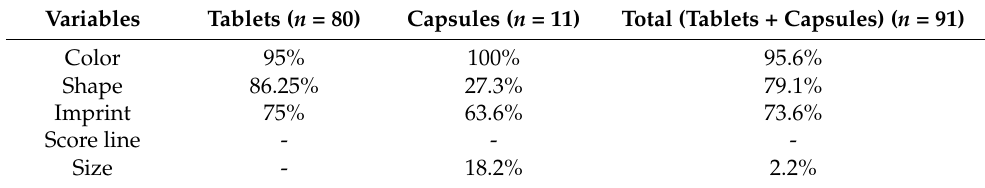
Table 2. Summary of the frequency test results based on the solid dosage forms available.